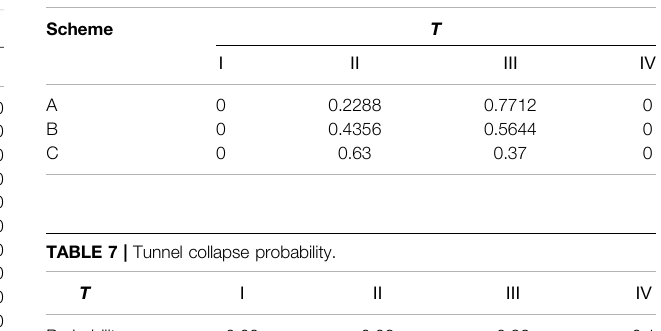
TABLE 6 | Probability distribution of tunnel collapse ( T ).